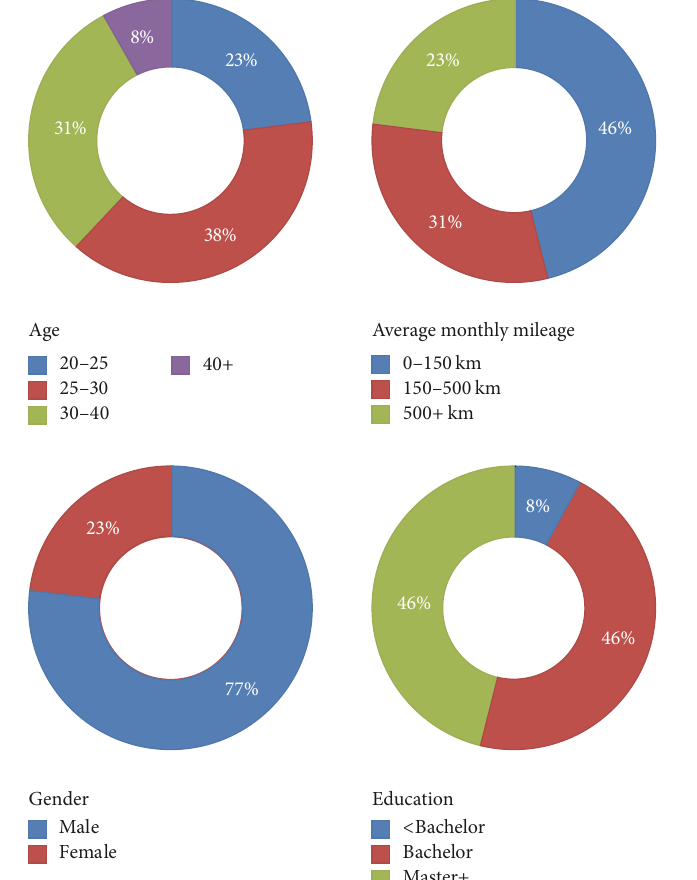
Figure 3: Drivers’ background